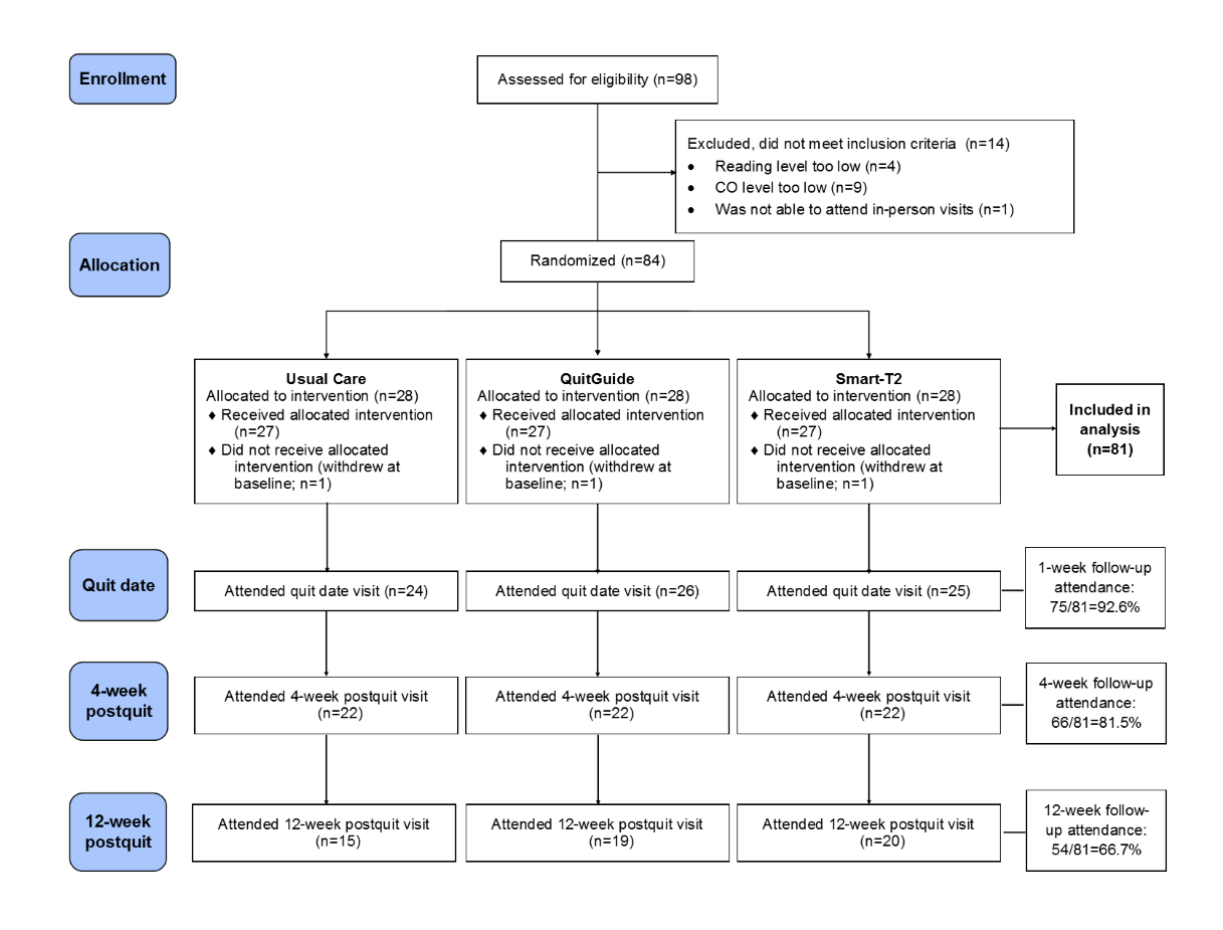
Figure 2. Consolidated Standards of Reporting Trials diagram. CO: carbon